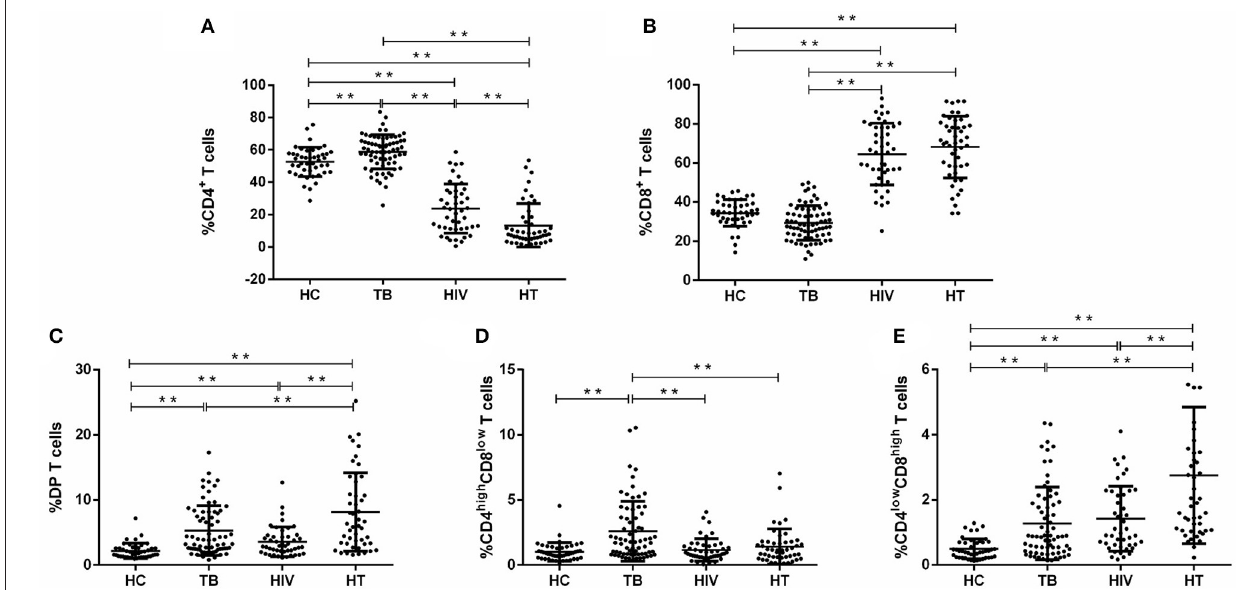
FIGURE 2 | Proportions of CD3 + T-lymphocyte subsets among each group. The percentage of CD4 + , CD8 + , and CD4 + CD8 + (DP), [ (A–C) , respectively], and CD4 high CD8 low and CD4 low CD8 high subsets of DP T cells [ (D,E) , respectively] among gated CD3 + lymphocytes are shown. P -value calculated using the Mann–Whitney U test. Statistically significant differences between the groups are indicated as follows: * p < 0.05 and ** p <